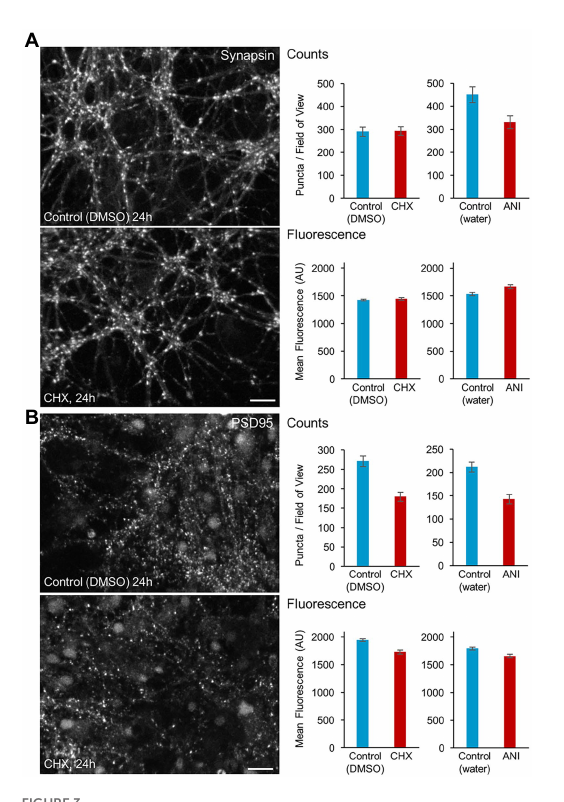
FIGURE 3 Effects of protein synthesis inhibitor treatment on synaptic persistence. Cortical neurons were grown for 2.5 weeks in cell culture wells (8 mm diameter cylinders adhered to coverslips). Matched cell culture wells (2–4 per condition) were treated with protein synthesis inhibitors or vehicle solutions for 24 h, fixed and stained with antibodies against the presynaptic protein Synapsin (A) and the postsynaptic protein PSD-95 (B) . Synapse numbers per field of view and molecular contents (mean fluorescence values) were quantified programmatically and compared. Bars: Synapsin: 10 μ m, PSD-95: 20 μ m. Mean ± SEM of data collected in separate fields of view. >30 fields of view from at least 2 cell culture wells per condition. See Supplementary Figure S2 for presentation by